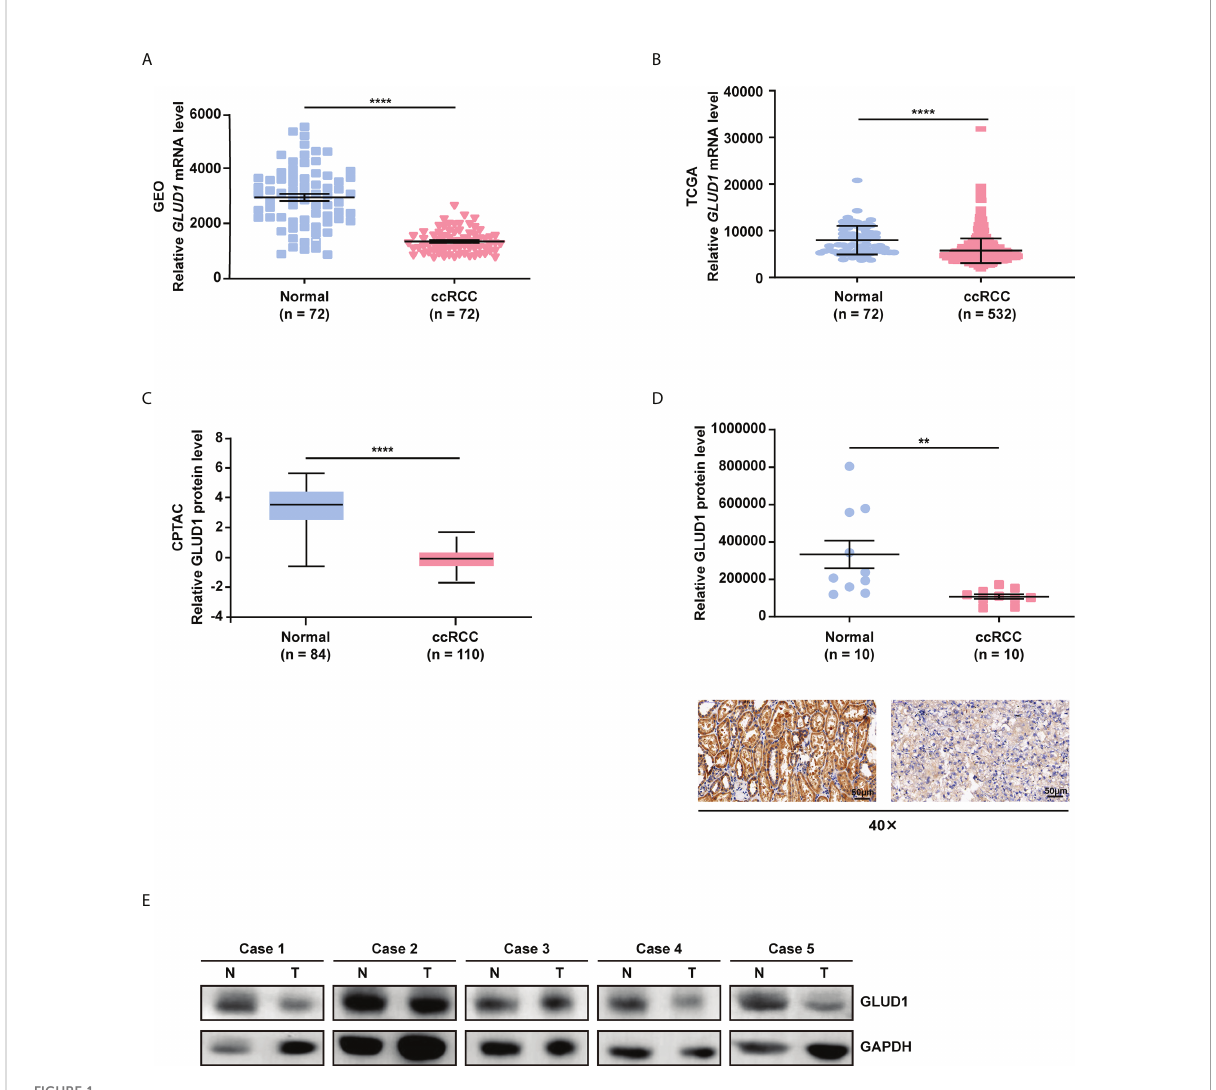
FIGURE 1 GLUD1 is downregulated in ccRCC tissues. (A, B) GLUD1 mRNA levels in ccRCC tissues compared with normal tissues based on GEO GSE53757 data (A) and TCGA_KIRC data (B) respectively. (C) GLUD1 protein levels in ccRCC tissues compared with adjacent normal tissues based on CPTAC data. (D) GLUD1 protein levels in ccRCC tissues and normal tissues were detected using IHC. Scatter plot displaying the expression of GLUD1 in adjacent normal tissues and ccRCC tissues. (E) GLUD1 protein levels in ccRCC tissues and paired normal tissues were detected using western blot assay. ** P < 0.01; **** P <